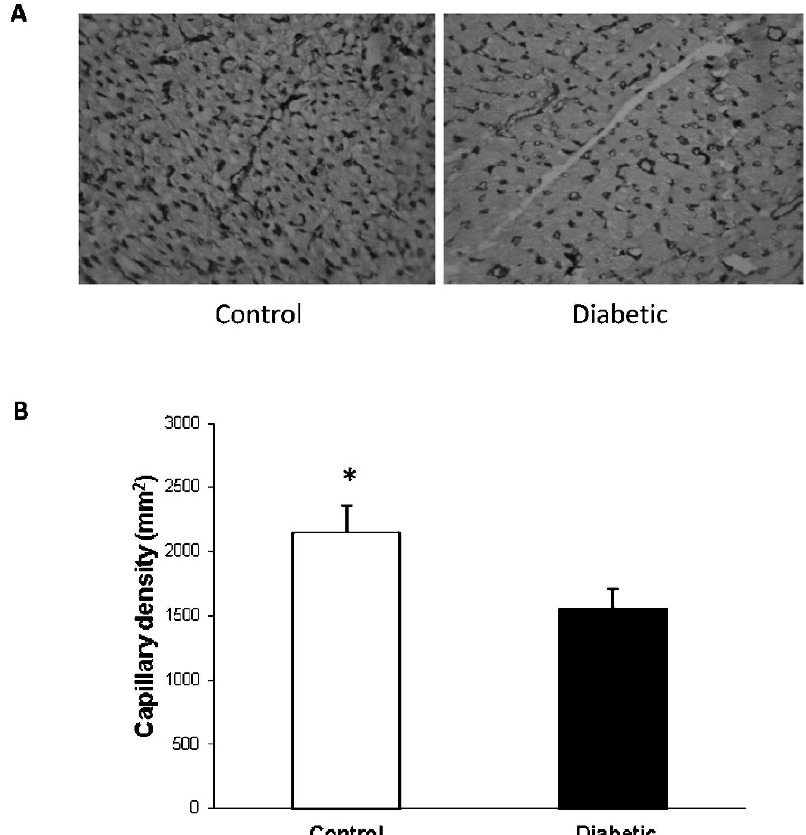
Figure 3 - Effect of diabetes on the myocardial capillary density. A. Representative images of the immunohistochemical staining (400 6 ) with an anti-CD31 monoclonal antibody. B. Myocardial capillary density in the control and diabetic groups. n =6 per group. * p